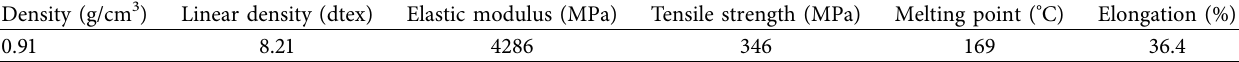
Table 2: Glass fiber parameters.